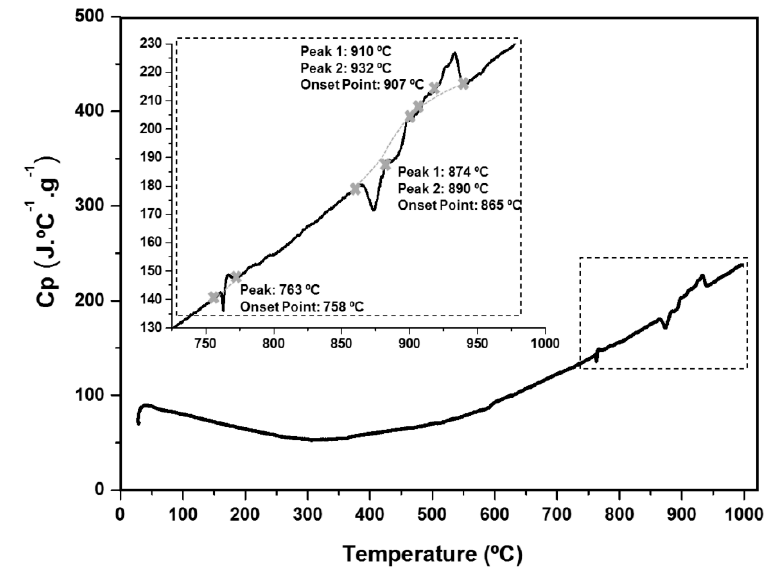
Figure 3. Differential scanning calorimetry (DSC) curve for the Ag-Cu sputtered coated Ti brazing filler.